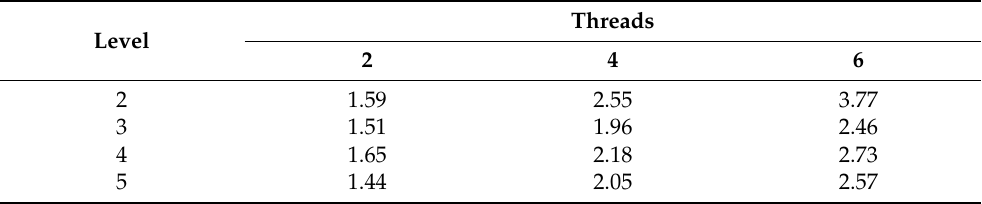
Table 10. Speedup of parallel V cycle of AGAMG in combination with deflation technique and MGenFAspI with droptol = 0 and l fill = 2 for 3D Poisson model problem with nx =